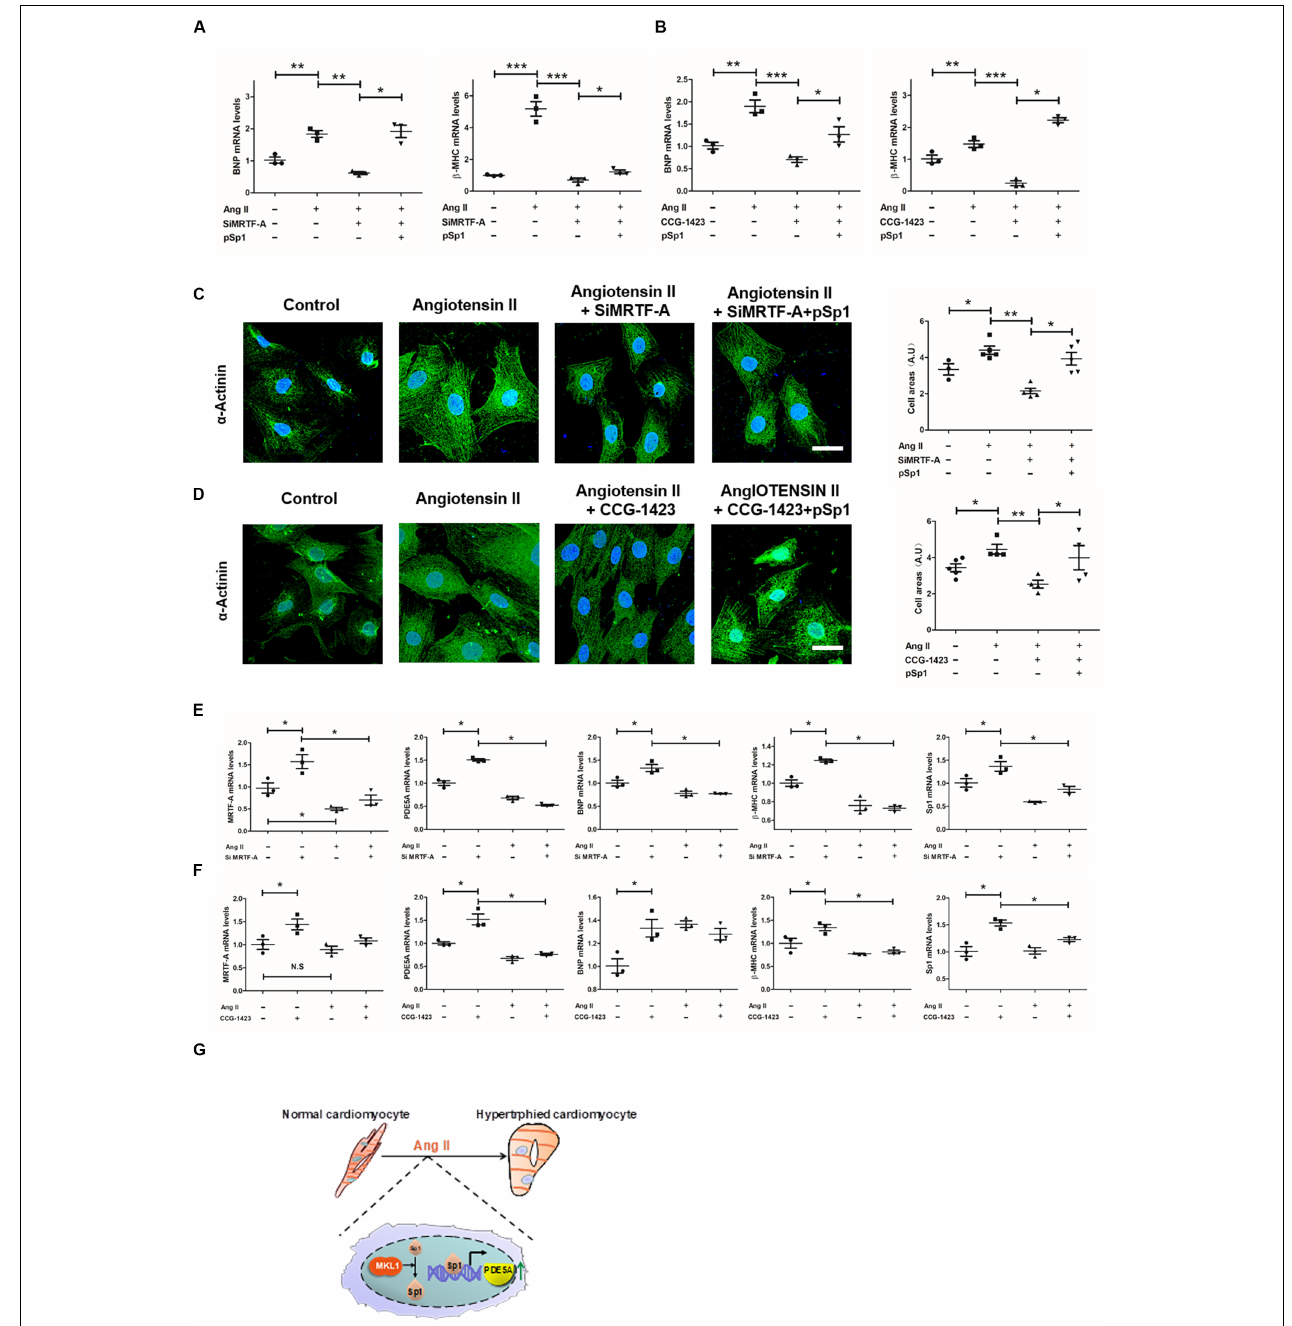
FIGURE 6 | Sp1-mediated phosphodiesterase 5 (PDE5) transcription is essential for myocardin-related transcription factor A (MRTF-A) to mediate Ang-II-induced prohypertrophic response in cardiomyocytes. (A) H9C2 cells were transfected with siRNA targeting MRTF-A or scrambled siRNA (SCR) in the presence or absence of ectopic Sp1 followed by treatment with Ang II (1 µ M) for 24 h. Gene expression was examined by quantitative PCR (qPCR). (B) H9C2 cells were treated with Ang II (1 µ M) and CCG-1423 (10 µ M) in the presence or absence of ectopic Sp1 for 24 h. Gene expression was examined by qPCR. (C) H9C2 cells were transfected with siRNA targeting MRTF-A or scrambled siRNA (SCR) in the presence or absence of ectopic Sp1 followed by treatment with Ang II (1 µ M) for 24 h. Immunofluorescence staining was performed with anti- α -actinin. Cross-sectional areas were quantified by Image Pro. (D) H9C2 cells were treated with Ang II (1 µ M) and CCG-1423 (10 µ M) in the presence or absence of ectopic Sp1 for 24 h. Immunofluorescence staining was performed with anti- α -actinin. (E) Primary neonatal rat ventricular myocytes were transfected with siRNA targeting MRTF-A or scrambled siRNA (SCR) followed by treatment with Ang II (1 µ M) for 24 h. Gene expression was examined by qPCR. (F) Primary neonatal rat ventricular myocytes were treated with Ang II (1 µ M) and CCG-1423 (10 µ M) for 24 h. Gene expression was examined by qPCR. (G) A schematic model. Data represent averages of three independent experiments, and error bars represent SEM. * p < 0.05; ** p < 0.01; *** p < 0.001. Scale bar: 25 µ